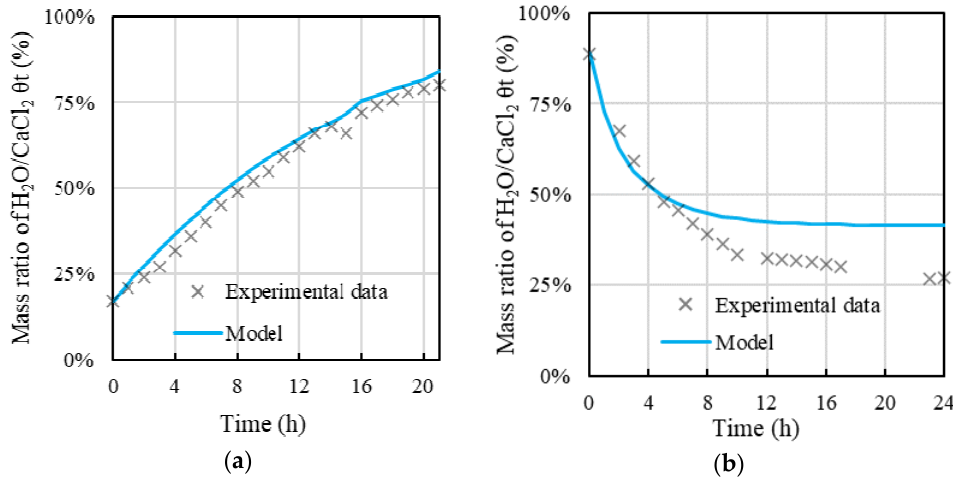
Figure 16. Actual against model ( a ) absorption at 25 °C and ( b ) desorption at 45